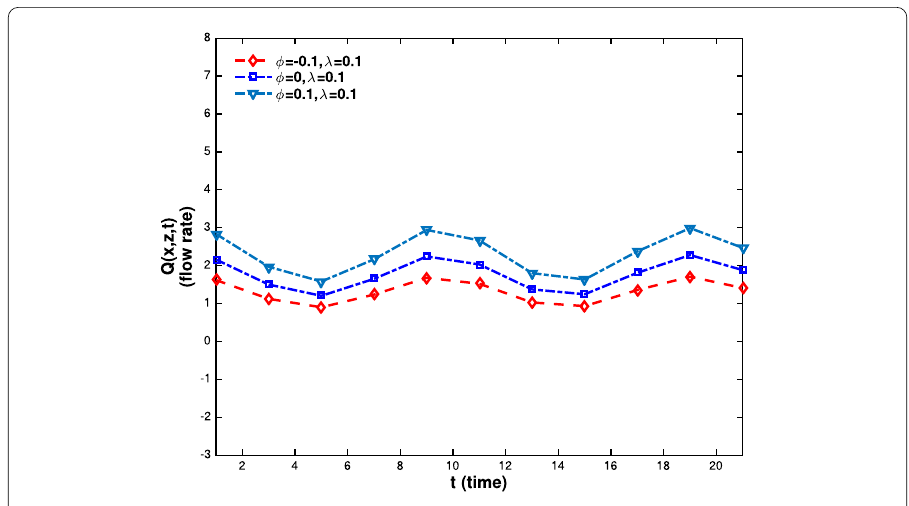
Figure 28 Flow rate vs time for φ = –0.1,0,0.1 at z = 28, τ y = 0.4, K = 1.6, λ =